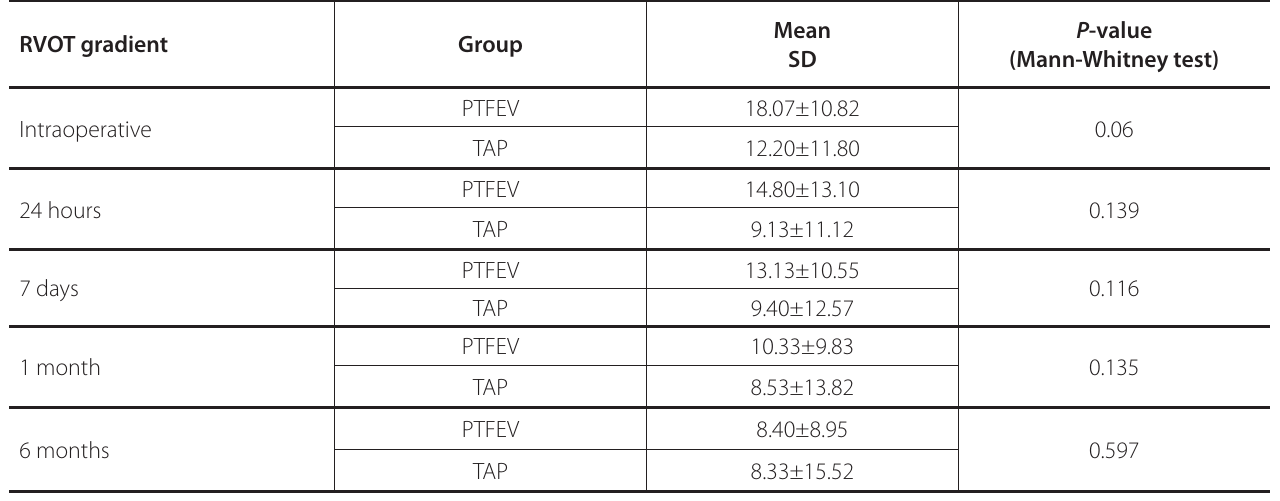
Table 5 . Progression of the right ventricular outflow tract gradient.